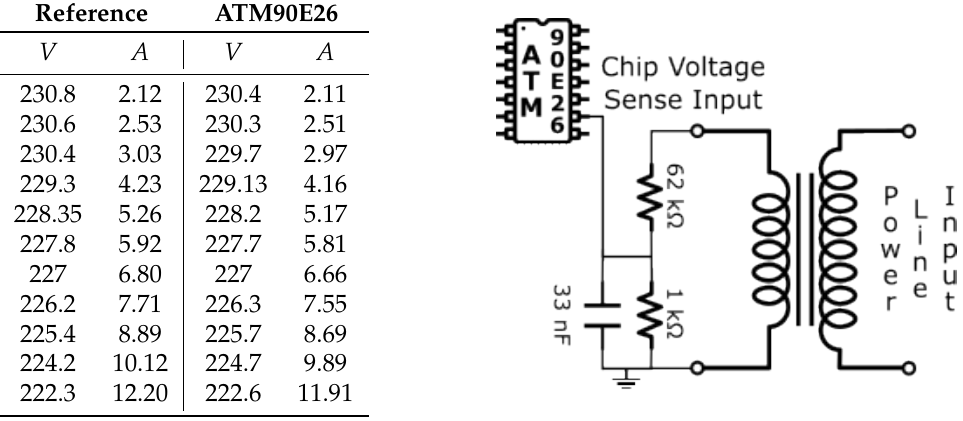
Figure 6. AC transformer and resistive voltage divider test. Error